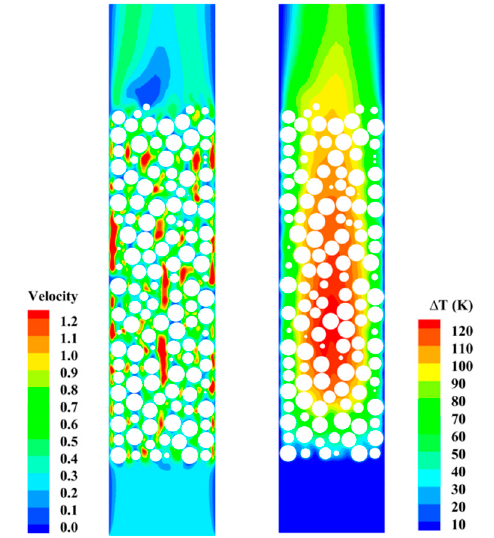
Figure 11. The distribution of velocity ( left ) and temperature ( right ) in an axial plane at t = 150 s.